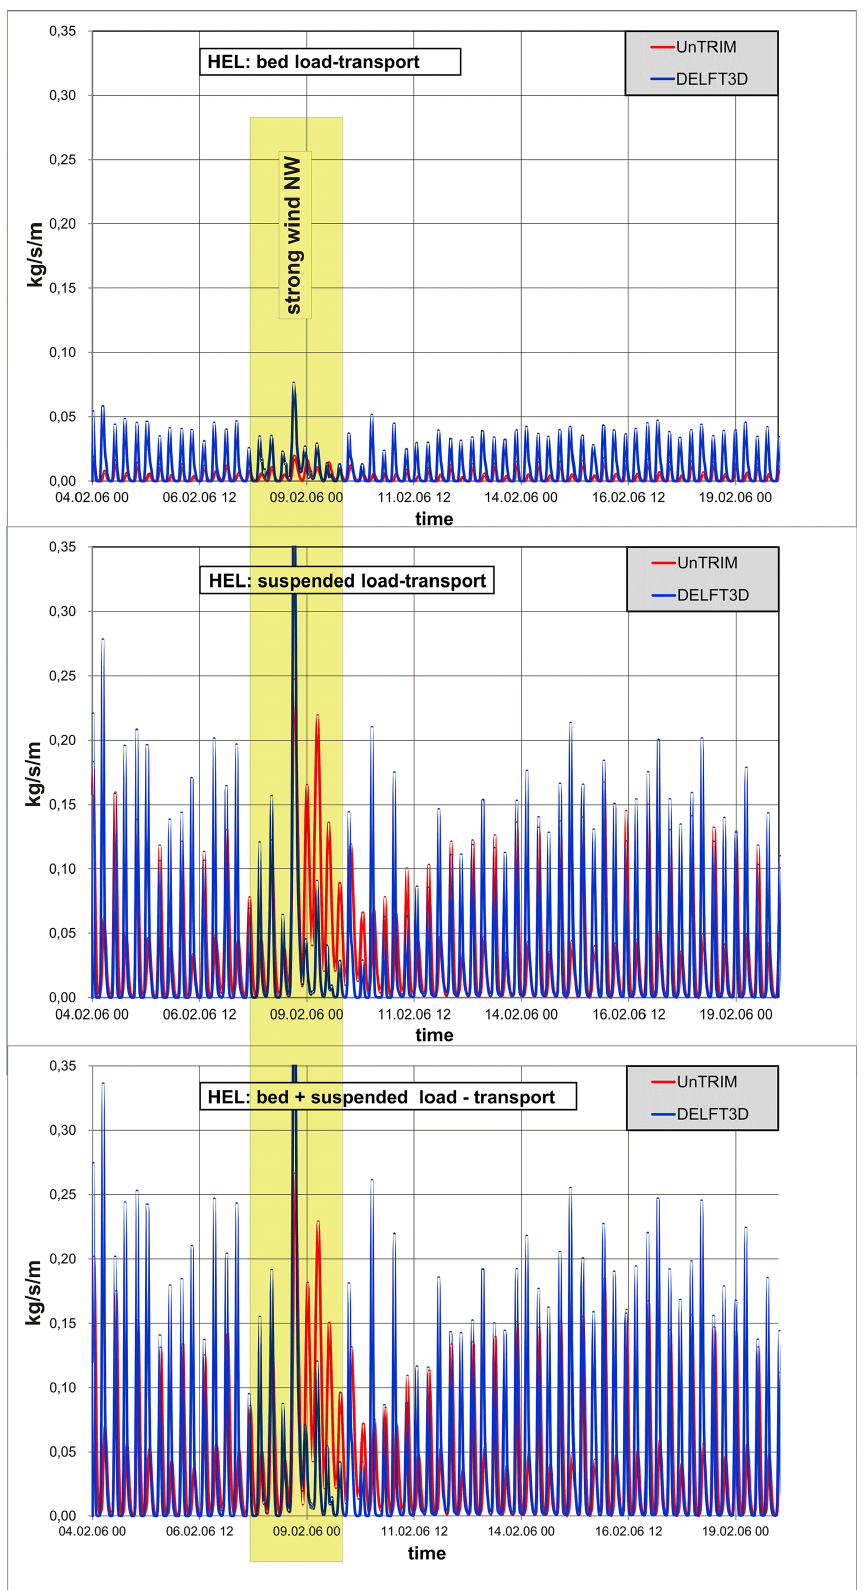
Fig. 5. Calculation of bed load, suspended load and total load transport at Helgoland (February 2006) derived from UnTRIM/UnK/SediMorph and DELFT3D(2-D